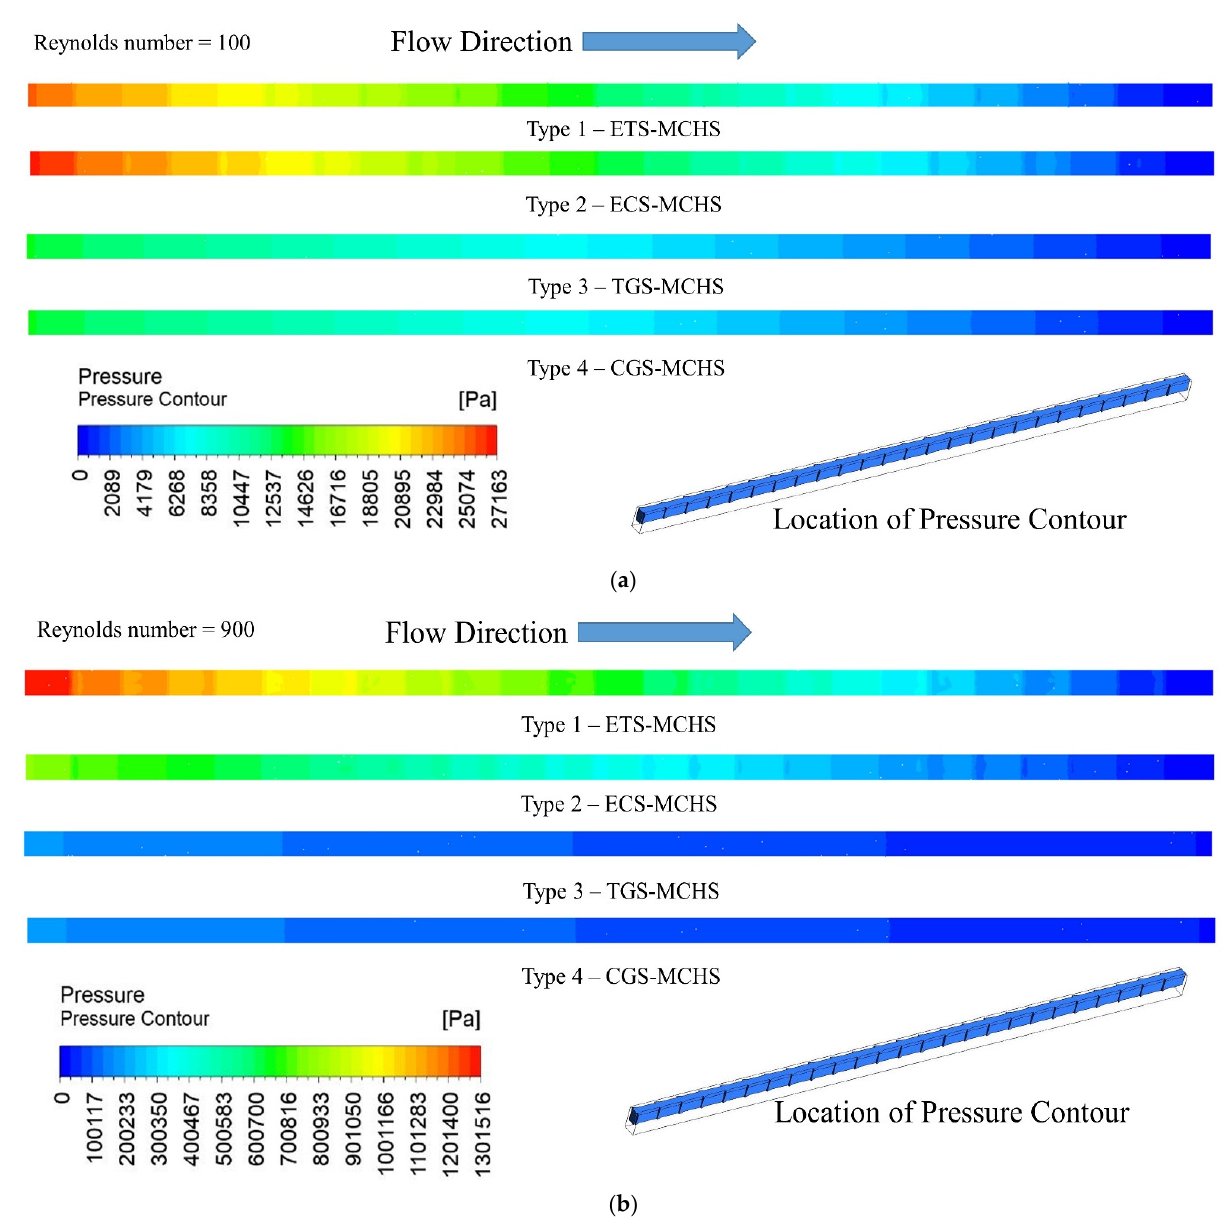
Figure 6. Pressure contour of heat transfer fluid in fluid domain for ( a ) Re= 100 and ( b ) Re = 900.